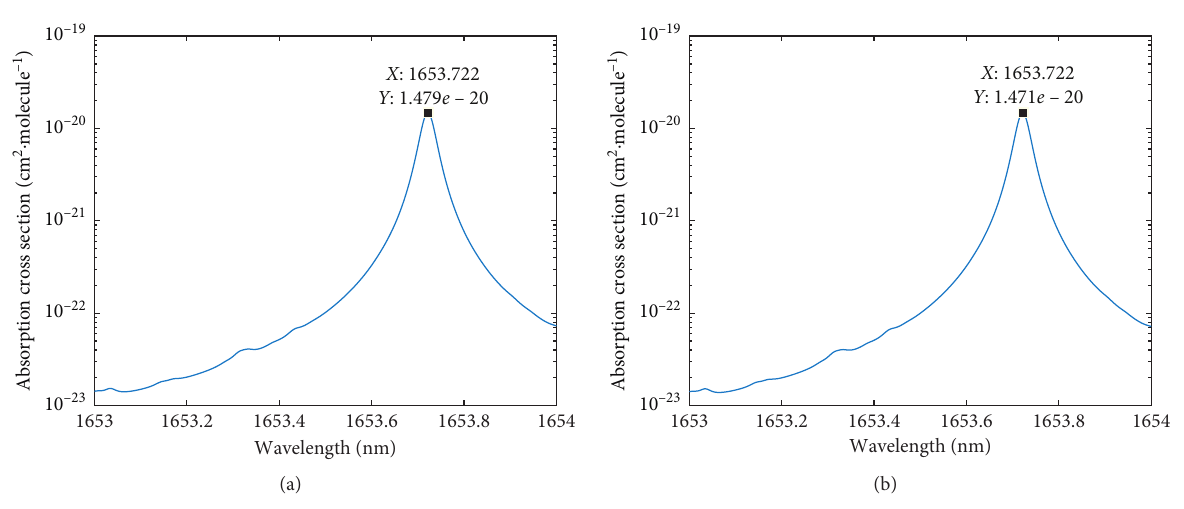
Figure 12: Effect of temperature change on methane absorption cross section at (a) 25 ° C and (b) 28 °